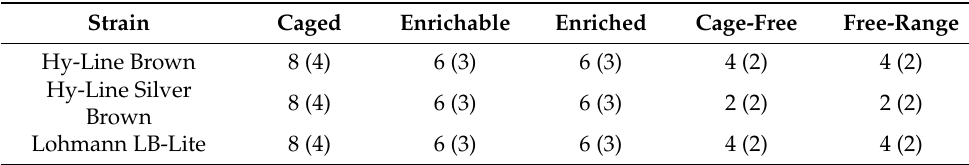
Table 1. Housing system and replicate allocation of strains during the lay cycle. Strain Caged Enrichable Enriched Cage-Free Free-Range Hy-Line Brown 8 (4) 6 (3) 6 (3) 4 (2) Hy-Line Silver